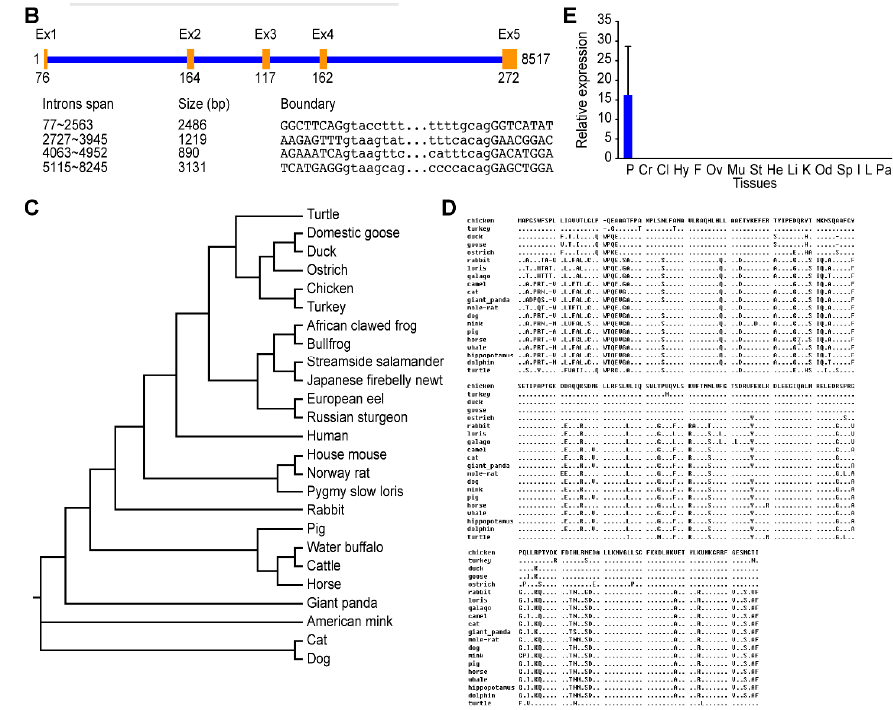
Figure 2. Chinemys reevesii GH cDNA sequence and gene characteristics. ( A ) The italic letters represent the 5 ′ - and 3 ′ -untranslated regions. The lowercase letters represent the coding sequence, with the corresponding protein sequence below. The shadowed letters represent ATG, TGA, tail signals, and the polyadenylation sequence aataaa in the 3 ′ -region. The primers GHF and GHR are single-underlined. The TGSP1 and TGSP2 5 ′ -RACE and 3 ′ -RACE primers are double-underlined; ( B ) Structural characteristics of C. reevesii GH gene. Capital letters are exon sequences; lower case letters are intron sequences; ( C ) Phylogenetic tree representing GH cDNA from various animal species; ( D ) Comparison of GH amino acid sequence homology in different species; ( E ) GH gene expression in various tissues from C. reevesii . P, pituitary; Cr, cerebrum; Cl, cerebellum; Hy, hypothalamus; F, fat; Ov, ovary; Mu, muscle; St, stomach; He, heart; Li, liver; K, kidney; Od, oviduct;